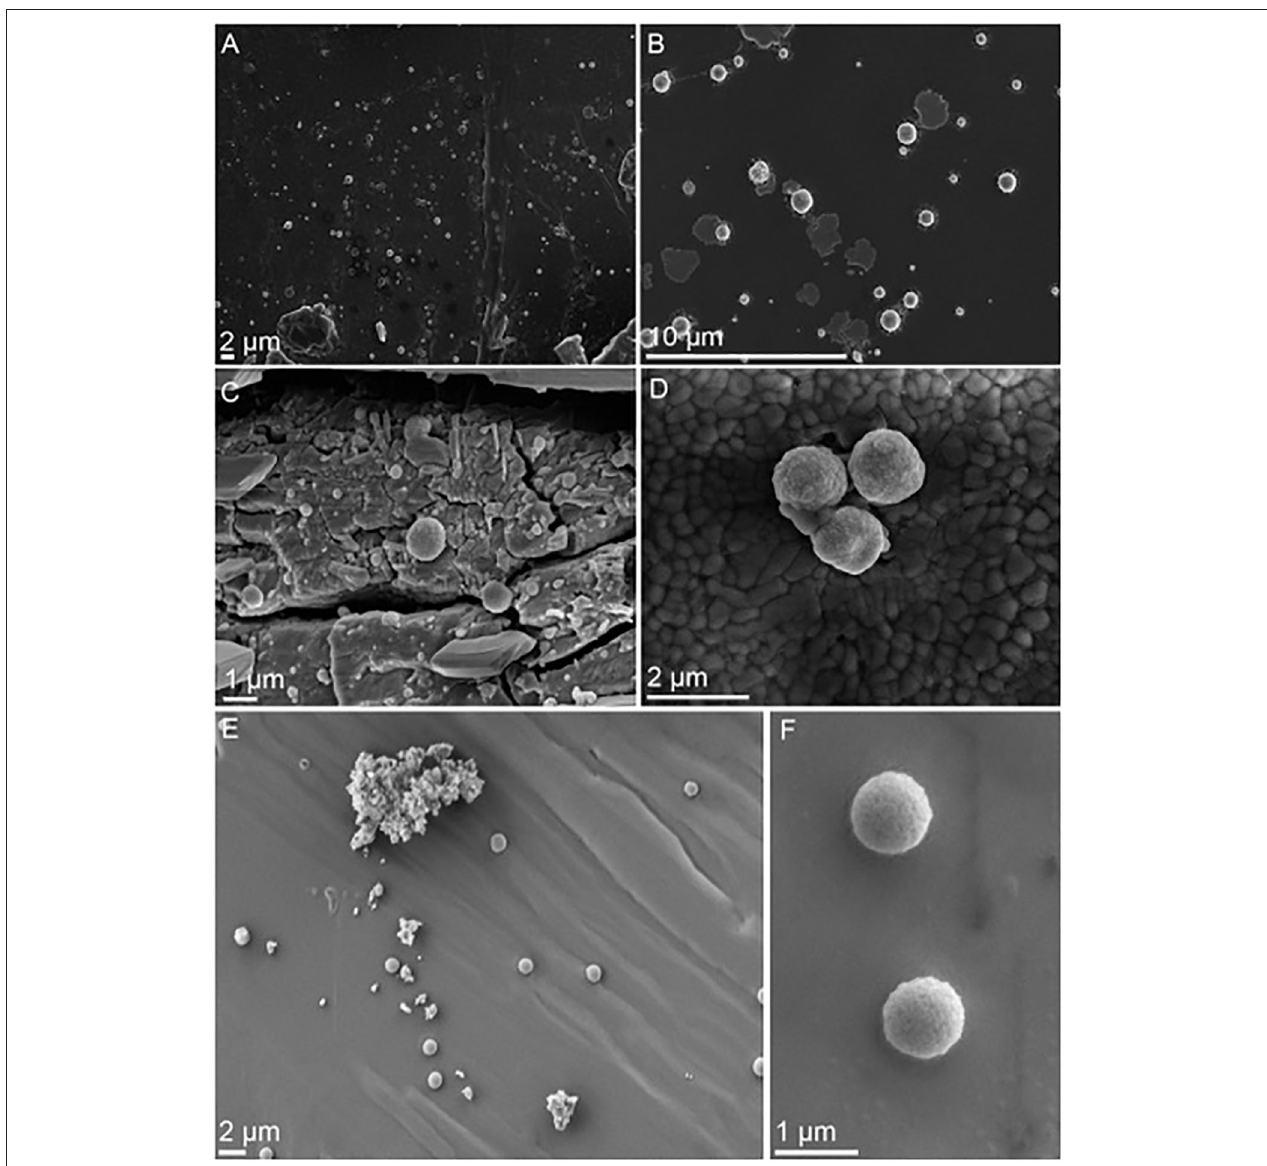
FIGURE 2 | SEM images showing desiccated cells of M. sedula cultivated with W-POM and multimetallic waste material after 2 months of dehydration. (A–D) SEM images of dehydrated M. sedula cells cultivated with W-POM. (E,F) SEM images of dehydrated M. sedula cells cultivated with multimetallic waste